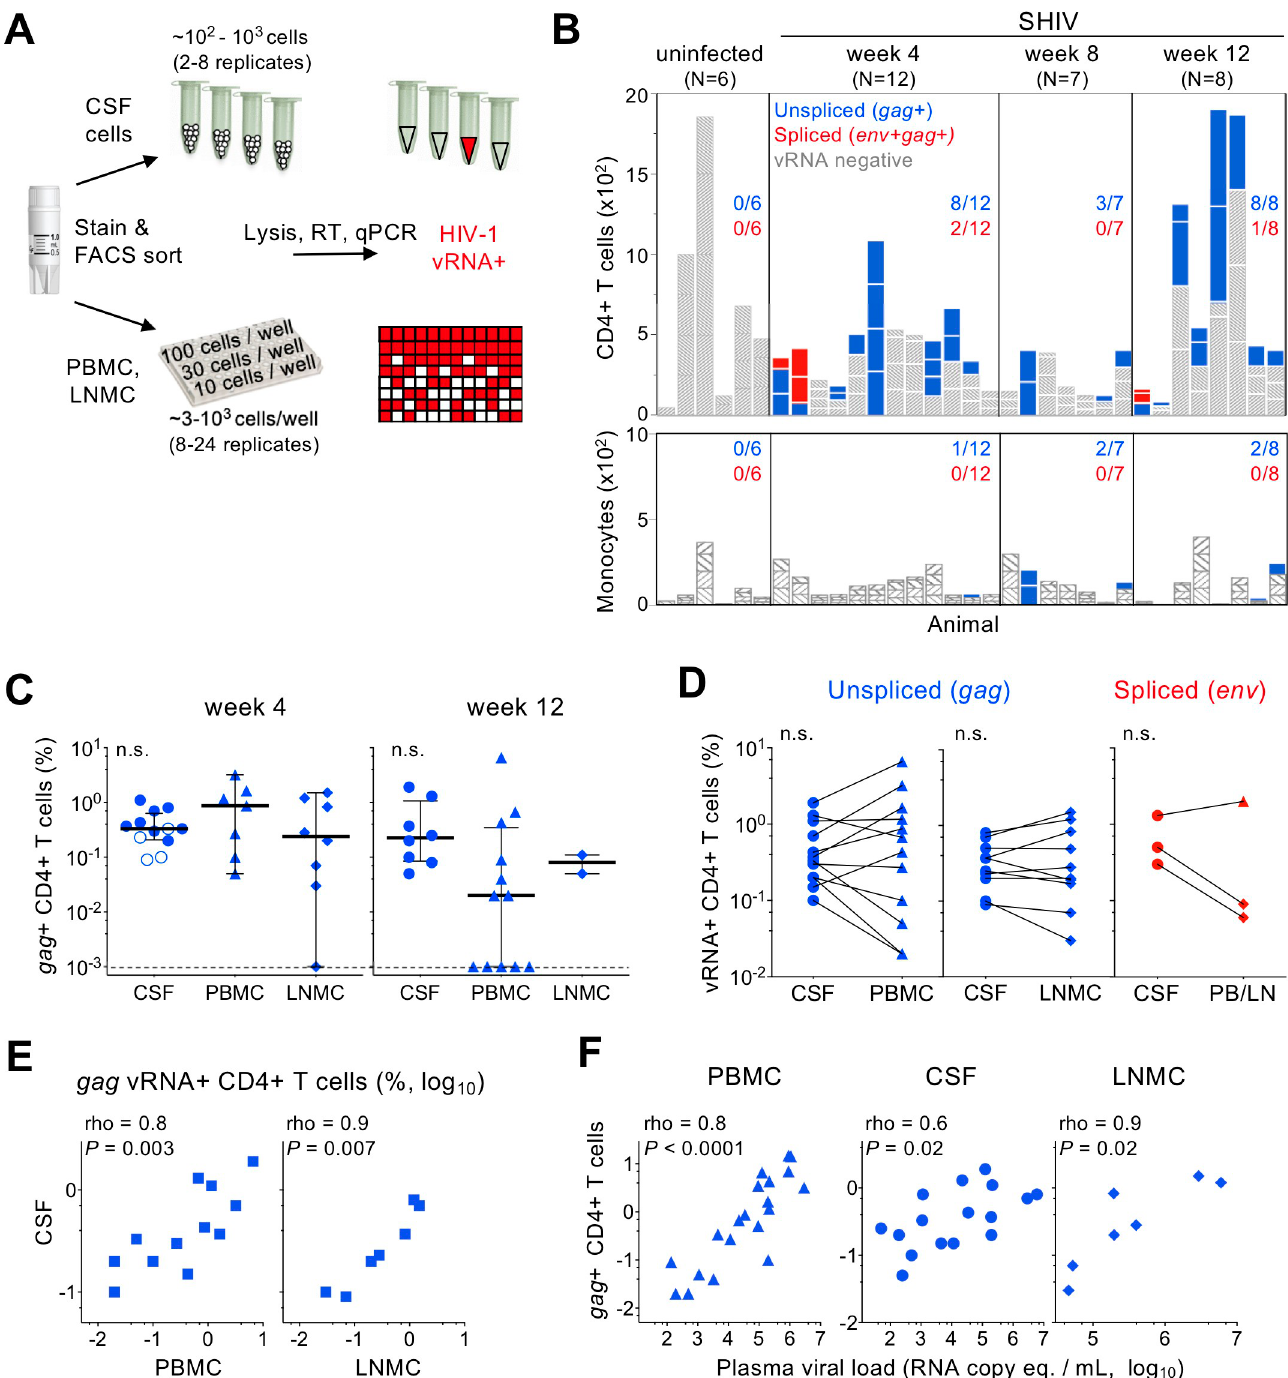
Fig 2. Cell-associated SHIV RNA during acute infection. (A) Schematic of workflow used to isolate mononuclear cell populations and estimate infected cell frequency in CSF (top) and PBMC or LNMC (bottom) directly ex vivo from SHIV-infected macaques. (B) Viral RNA RT-qPCR positivity among FACS sorted CD4+ T cells (top) and monocytes (bottom) in CSF of uninfected and SHIV-infected macaques 4, 8, and 12 weeks PI. The number of cells analyzed for each animals is indicated on the y-axis, with stacked bars reflecting the size of each sort replicate. Bar coloring indicates positivity for unspliced only (blue) or spliced (red) SHIV RNA; viral RNA-negative replicates are colored gray. Fraction of animals with SHIV RNA+ cells is indicated for each time point. (C) SHIV gag RNA + CD4+ T cell frequency is shown for CSF, PBMC, and LNMC 4 and 8 weeks PI. Open symbols depict the limit of detection in samples where no vRNA was detected. Significant differences between tissues was assessed using Mann-Whitney test. (D) Paired analysis comparing the infected CD4+ T cell frequency between matched CSF and either PBMC or LNMC is shown. (E) Correlation between gag vRNA+ infected CD4+ T cell frequency between CSF and PBMC (left)